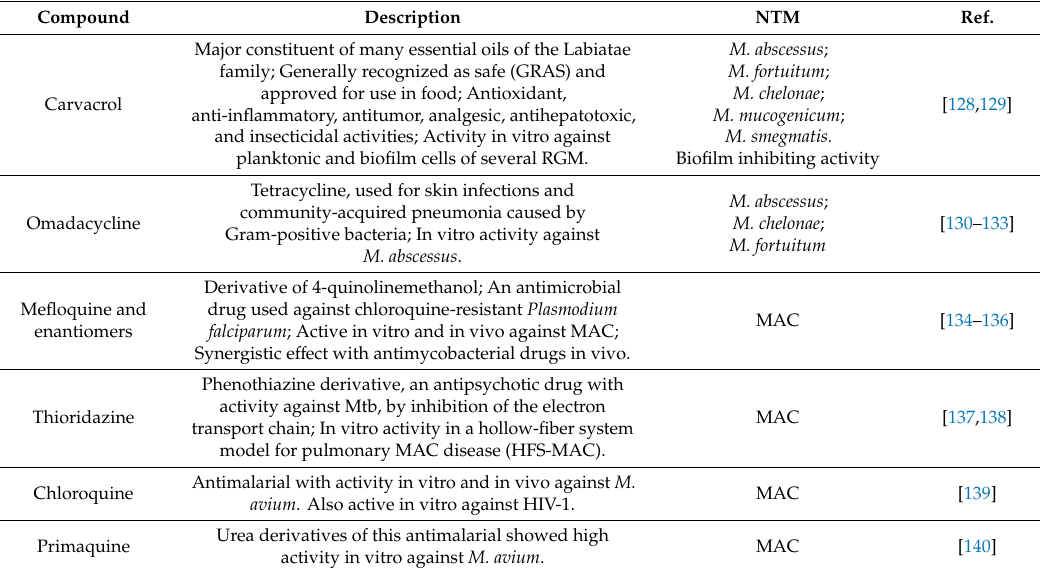
Table 2. Summary of recent publications showing repurposed drugs with favorable activity against NTM